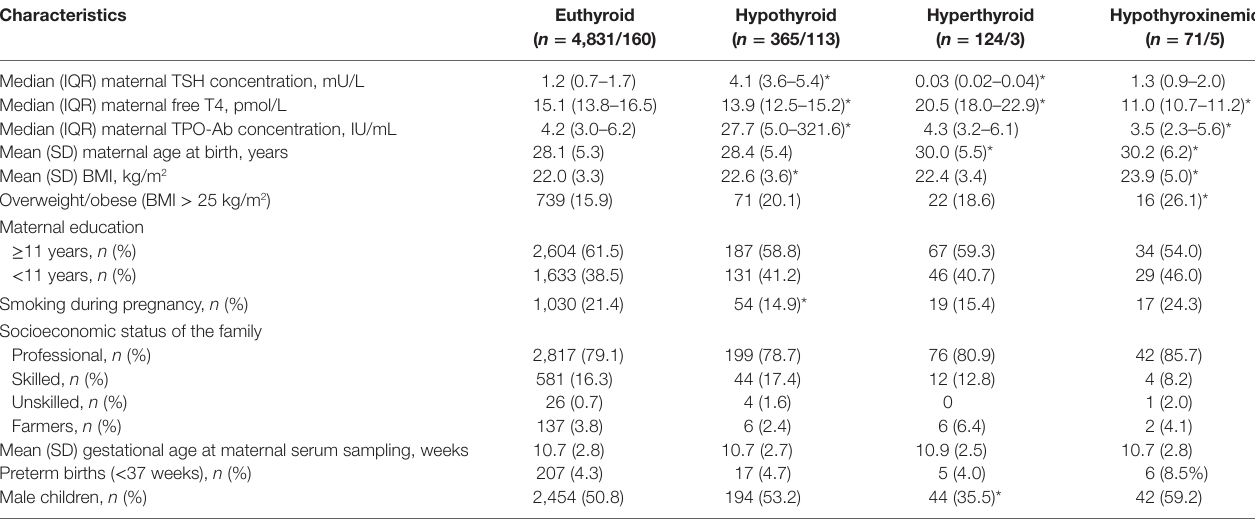
TaBle 1 | Maternal and family characteristics grouped by maternal thyroid function.